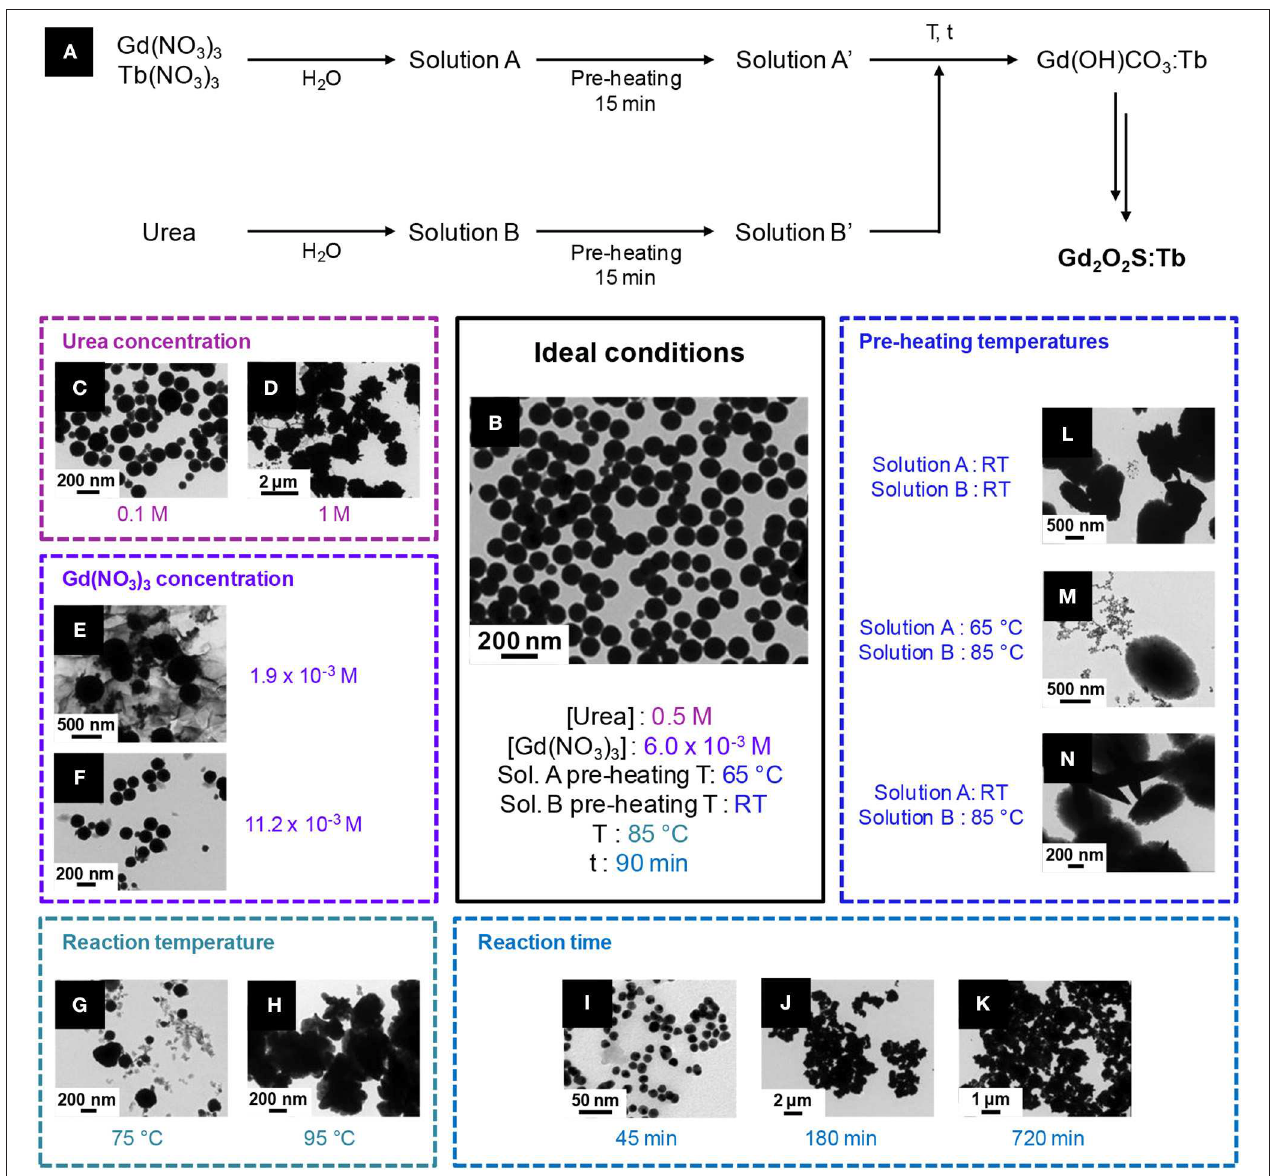
FIGURE 12 | Optimized synthesis of Gd 2 O 2 S:Tb nanoparticles by Hernández-Adame et al. (2014) (A) Synthetic strategy: the authors first synthesized from nitrates and urea a doped hydroxycarbonate precursor that was later converted to the oxysulfide. TEM micrographs of the final Gd 2 O 2 S:Tb nanoparticles in the optimized conditions (B) and of the different Gd(OH)(CO 3 ) particles obtained with through the optimization (C–N) . Only one parameter is changed at once, the others being identical to the optimal conditions. Adapted from Hernández-Adame et al. (2014) with permission of